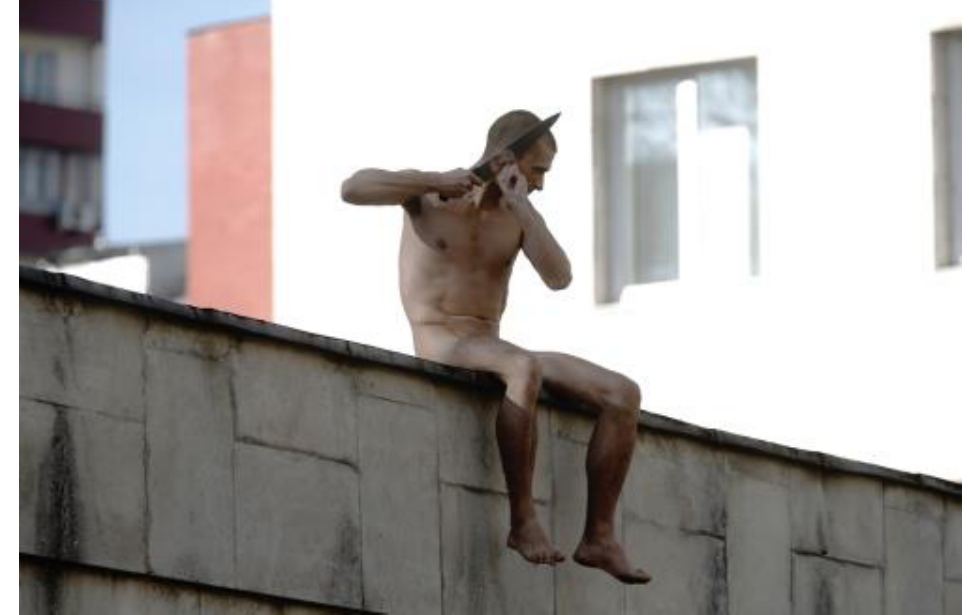
Petr Pavlensky, Segregation ( Oтделение ), October 19, 2014. Performance action with photographic documentation, Moscow, Russia. Photograph, 72 x 48 in. Photographer anonymous, image courtesy of Petr